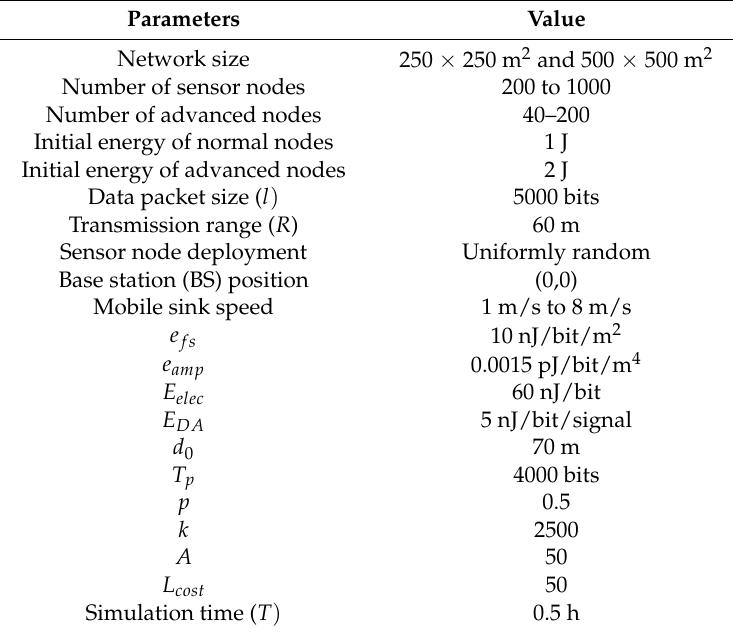
Table 5. List of the network parameters.